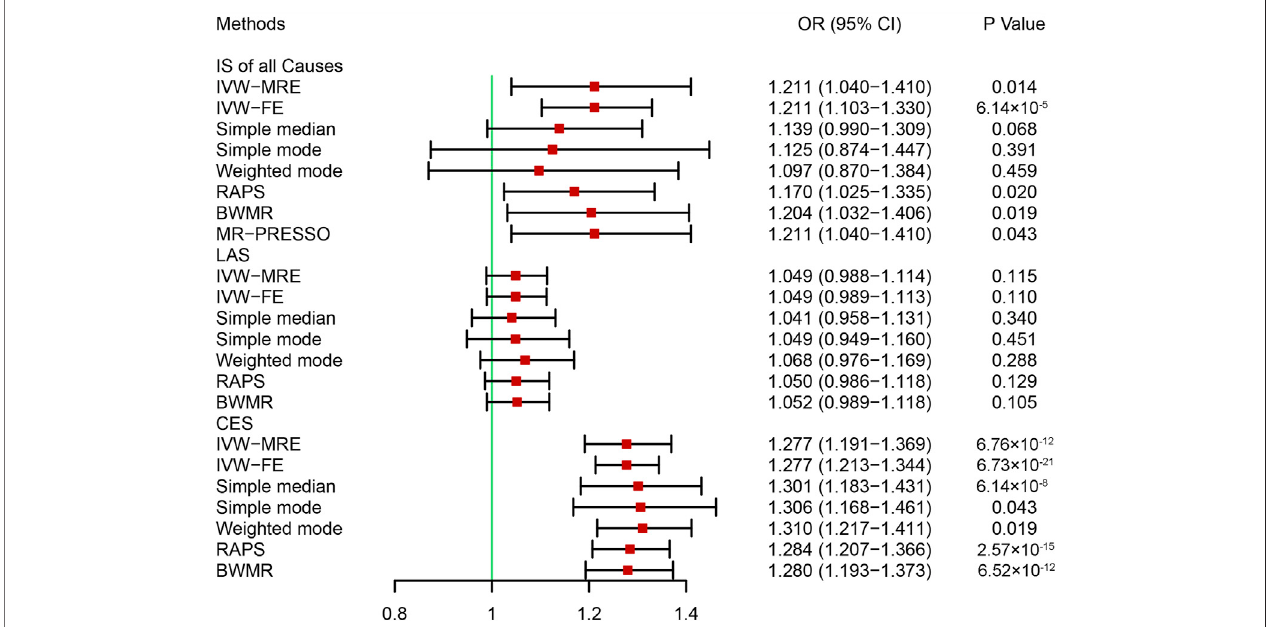
FIGURE 4 | Mendelian randomization analysis of the effect of ischemic stroke on heart failure. BWMR, Bayesian weighted Mendelian randomization; CES, cardioembolic stroke; CI, con fi dence interval; IS, ischemic stroke; IVW-FE, inverse variance-weighted- fi xed effects; IVW-MRE, inverse variance-weighted-multiplicative random effects; LAS: large artery atherosclerosis stroke; MR-PRESSO: Mendelian randomization pleiotropy residual sum and outlier; OR, odds ratio; RAPS, robust adjusted pro fi le score. Bonferroni corrected p -value (cid:1) 0.0017.